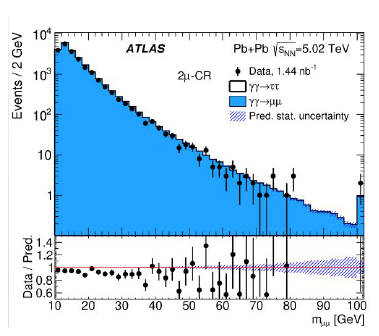
Figure 6. muon-muon invariant mass in 2 µ -CR region [6].